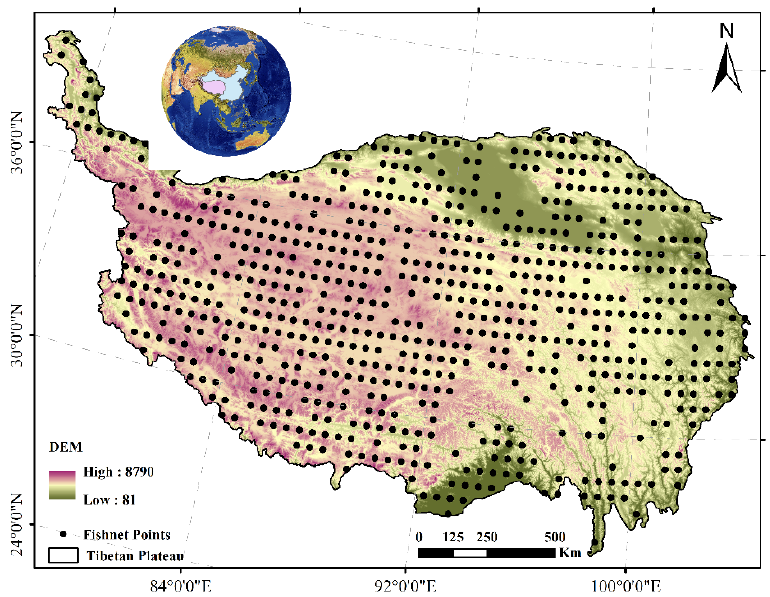
Figure 1. Study area; the depth of color represents the elevation in the